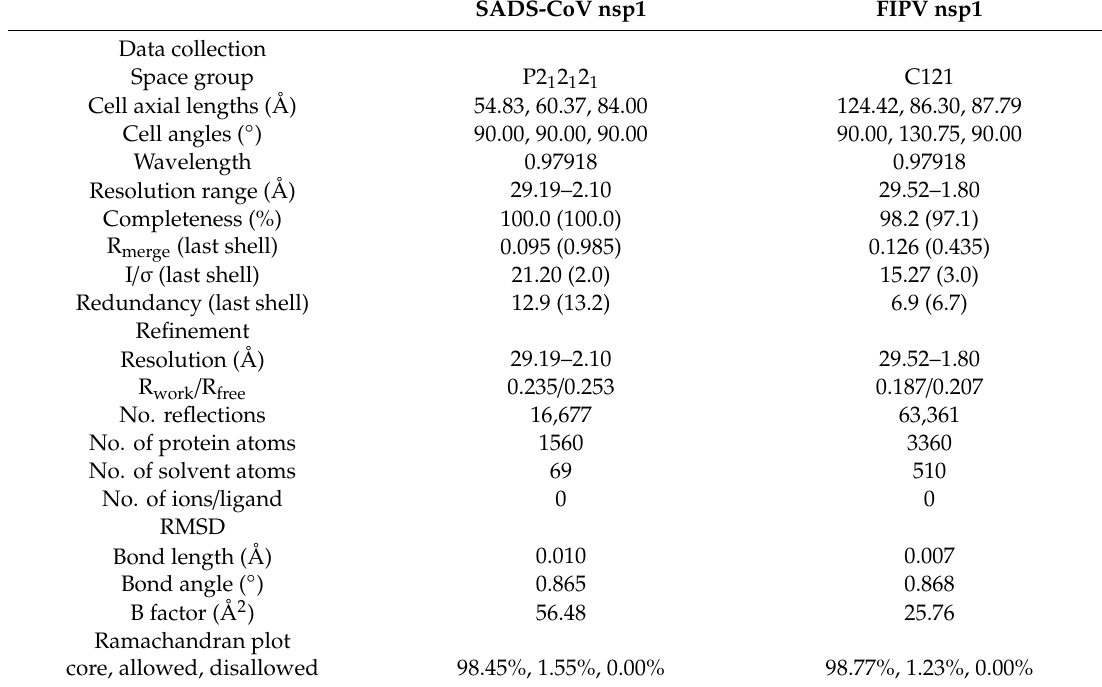
Table 1. Data collection and refinement